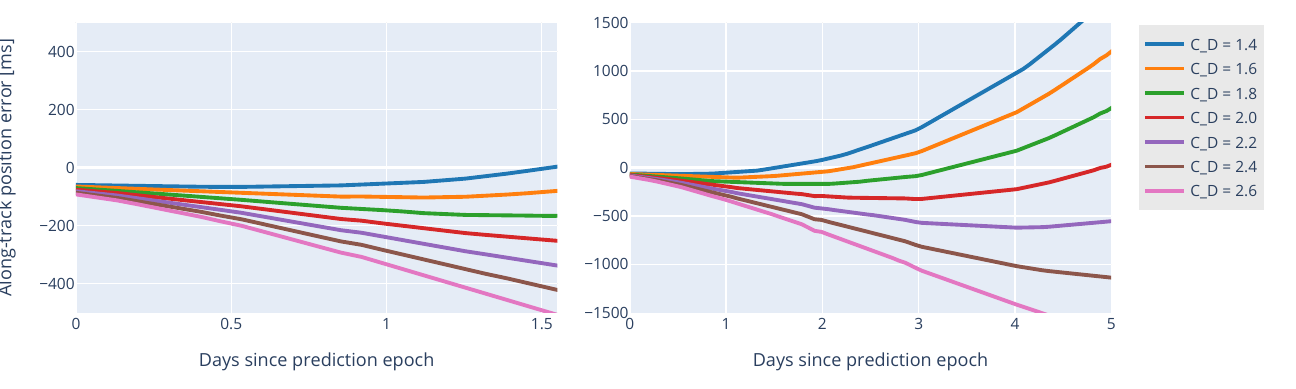
Figure 13. Evolution of time bias of multiple predictions with different drag coefficients C D for TUBIN on 6 September 2022, measured by comparison to subsequent GPS data. ( Left ) First 36 h after the prediction epoch. ( Right ) First 5 days after the prediction epoch.